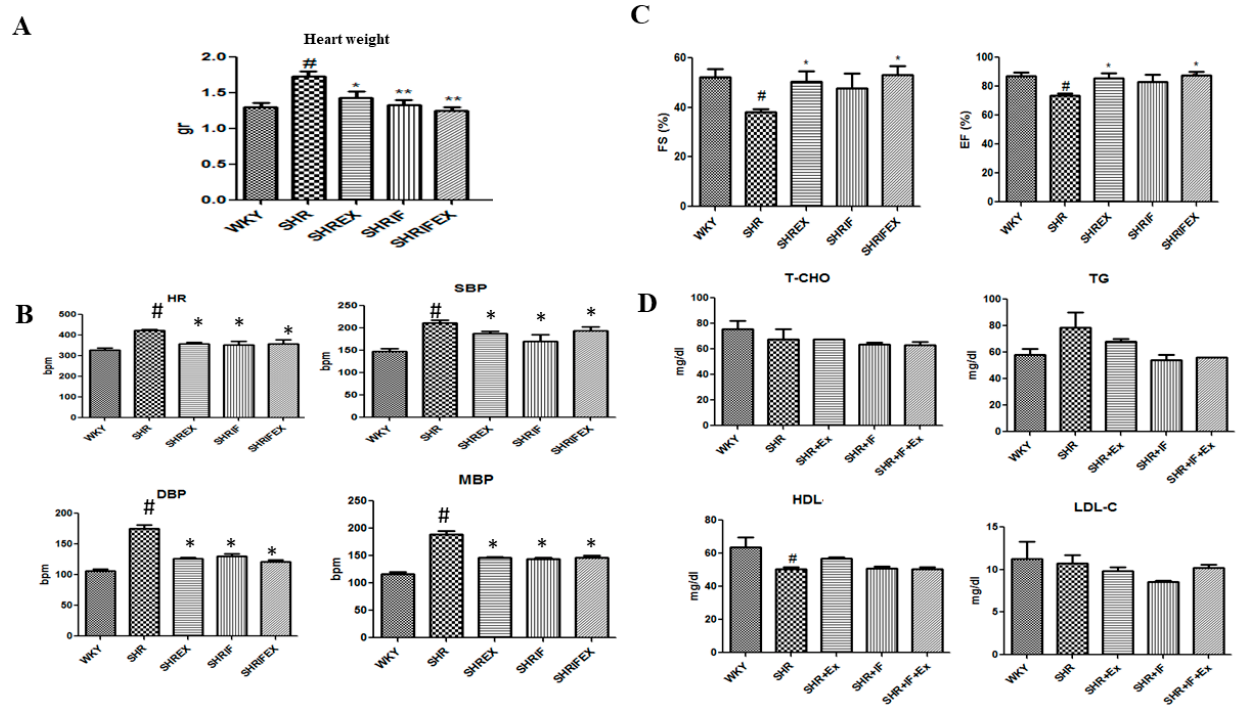
Figure 1. Effect of IF peptide and exercise training on heart weight, blood lipid profile, blood pres- sure ejection fraction, and fractional shortening parameters in hypertension rats. ( A ) Heart weight (gr, gram). ( B ) Blood parameters such as systolic blood pressure (SBP), diastolic blood pressure (DBP), mean blood pressure (MBP), and heart rate (HR). ( C ) EF, ejection fraction; FS, fractional shortening. ( D ) Blood lipid profile. T-CHO, total cholesterol; TG, triglycerides; HDL, high-density lipoprotein; LDL-C, low-density lipoprotein cholesterol. n = 8, # p < 0.01 compared to WKY, * p < 0.05, and ** p < 0.01 compared to SHR.